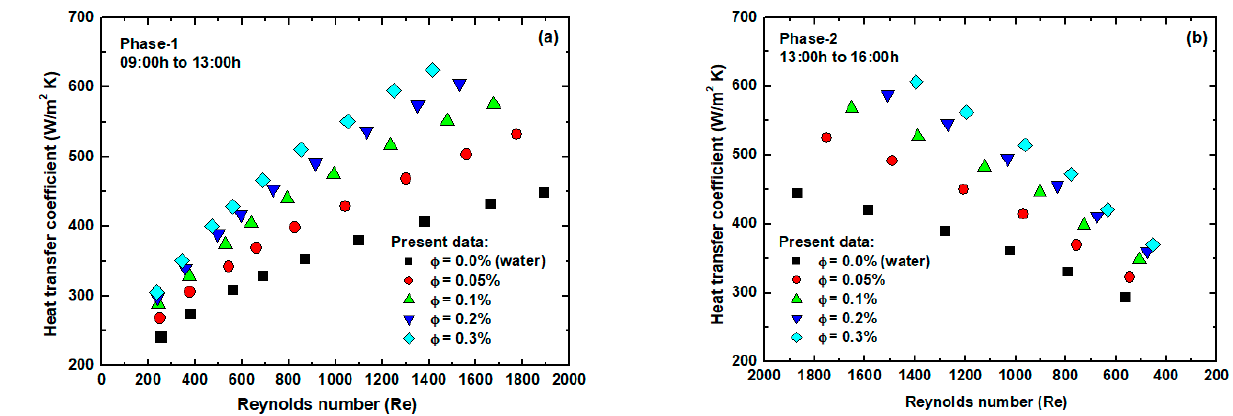
Figure 12. The hybrid nanofluids heat transfer coefficient; Phase-1 ( a ), and Phase-2 ( b ).